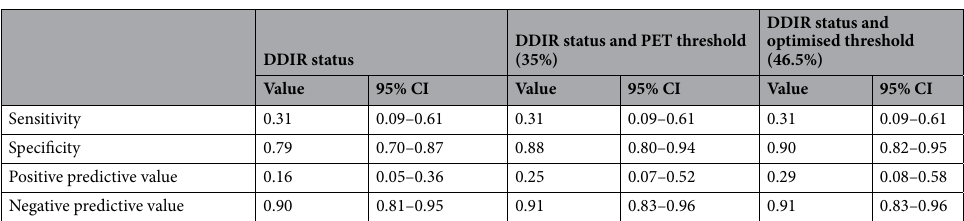
Table 3. Sensitivity, specificity, positive predictive value and negative predictive value for pathological response of DDIR Status, DDIR combined with a PET Threshold of 35% and with the optimised SUVmax reduction threshold.